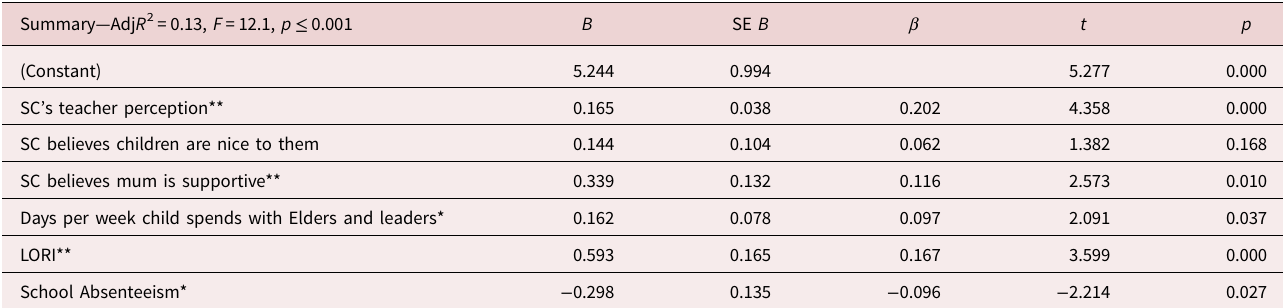
Table 4. Reading self-concept ×selected independent